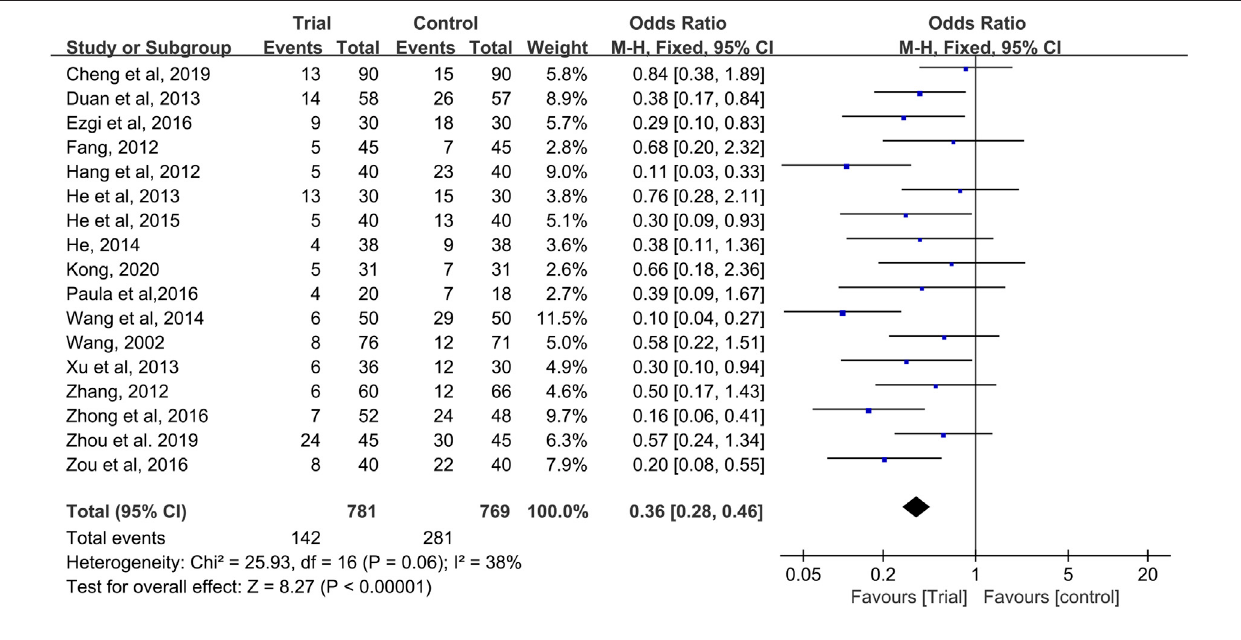
FIGURE 4 | Forest plots of incidence of grade I-II CIOM.